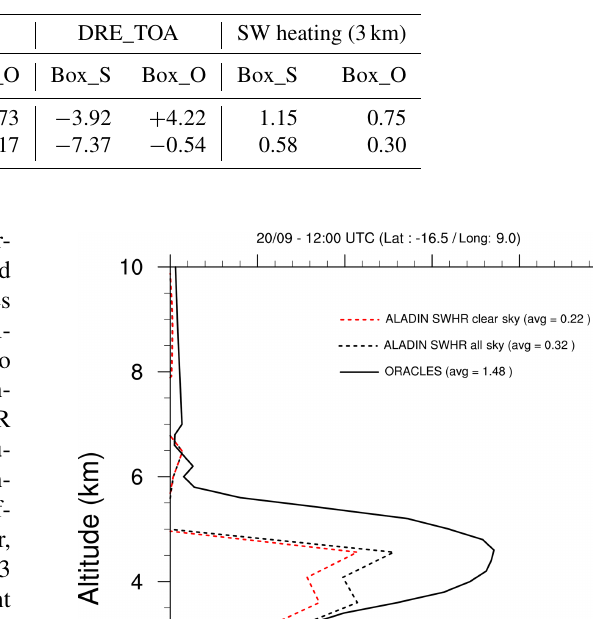
Table 3. Monthly mean (September 2016) all-sky direct radiative effect at TOA and bottom of the atmosphere (BOA; Wm − 2 ) and SW heating rate at 3km (Kday − 1 ) for the two boxes (box_S and box_O), obtained from the SMK and SMK_SSA simulations.